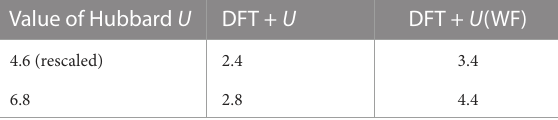
TABLE3 DifferentbondlengthscomputedforLNOcompound(Li x NiO 2 ) atdifferentdelithiationlevel.Theexperimentaldataarethoseof Molenda et al. (2002).